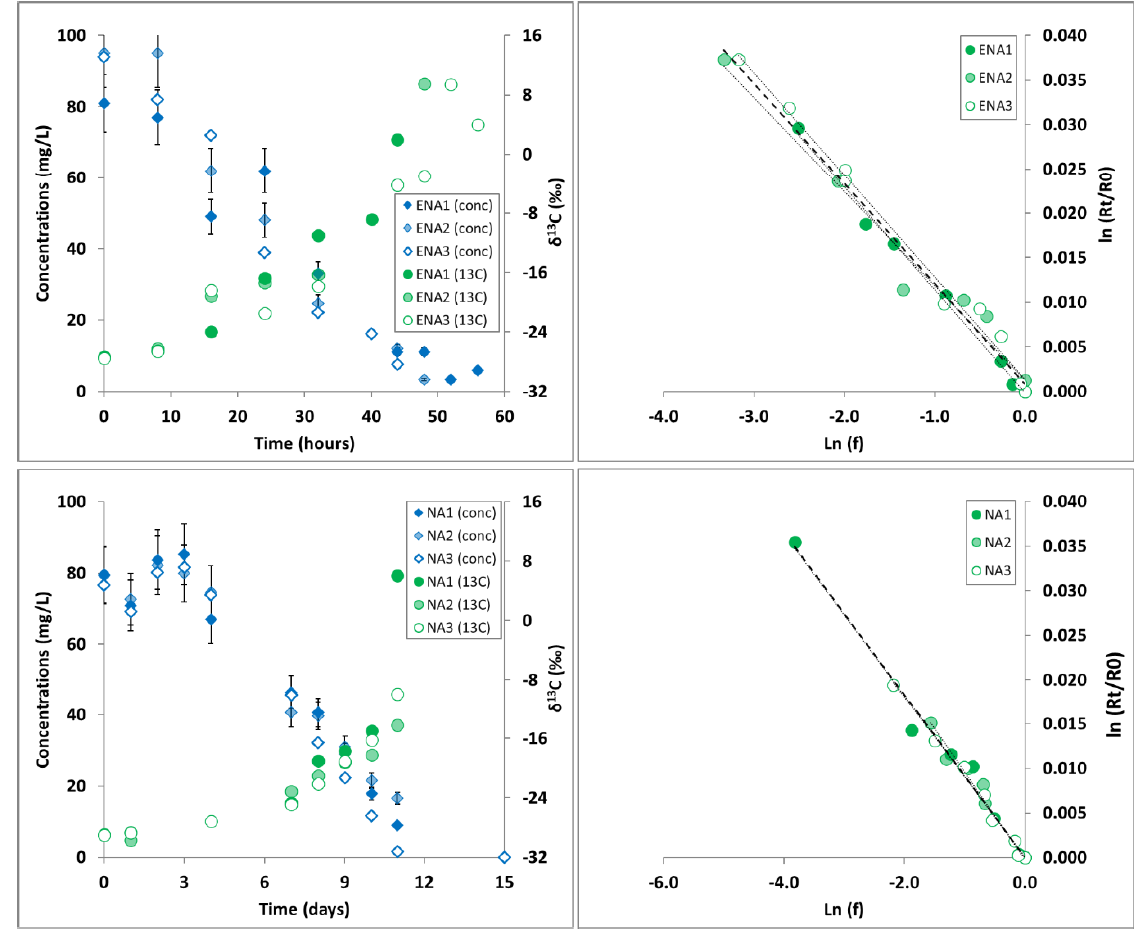
Figure 3. Microcosm experiments results: 1,2- DCA concentrations and δ 13 C results over time for enhanced natural attenuation (ENA) microcosm experiments; numbers 1 – 3 indicate experiment number) and natural attenuation (NA) (microcosm experiments; numbers 1 – 3 indicate experiment number) on the left; Ln (f) and Ln (Rt/R0) for enrichment factor estimation (on the right).